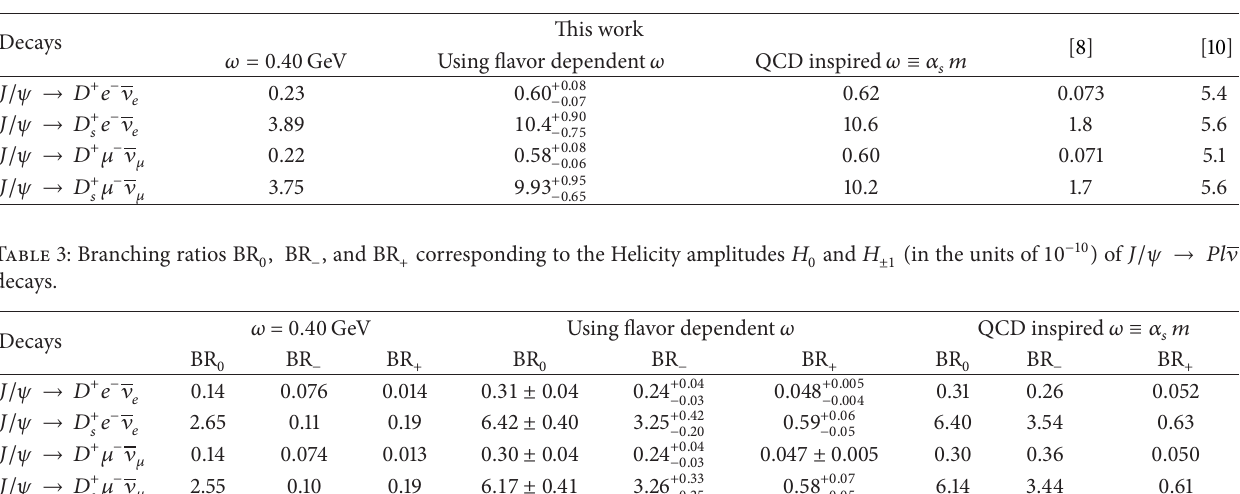
Table 2: Branching ratios (in the units of 10 −10 ) of 𝐽/𝜓 → 𝑃𝑙𝜈 decays.